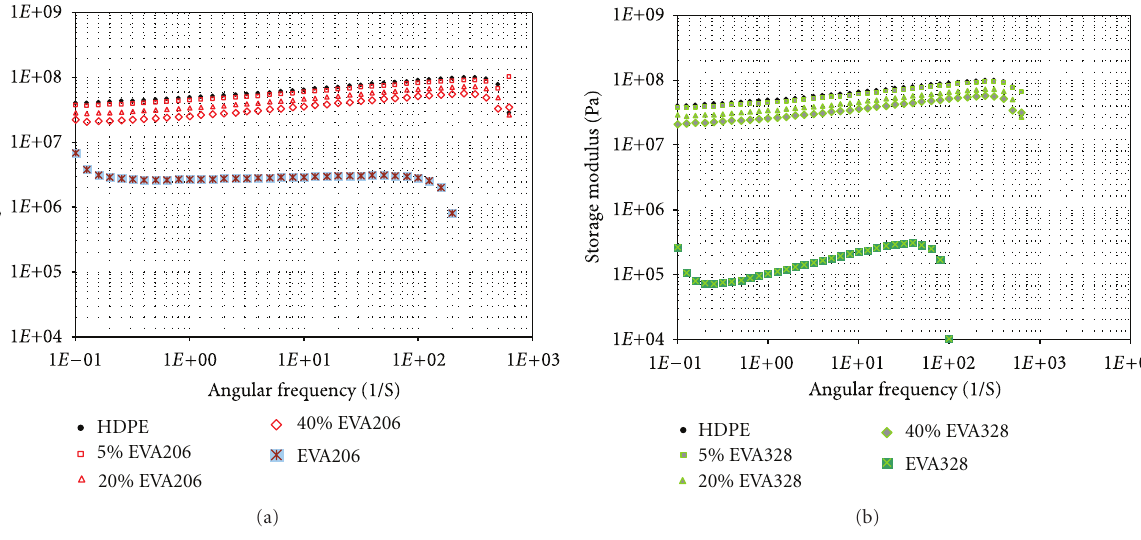
Figure 8: (a) Frequency sweep at 90 ◦ C for HDPE/EVA206 blends. (b) Frequency sweep at 90 ◦ C for HDPE/EVA328 blends.